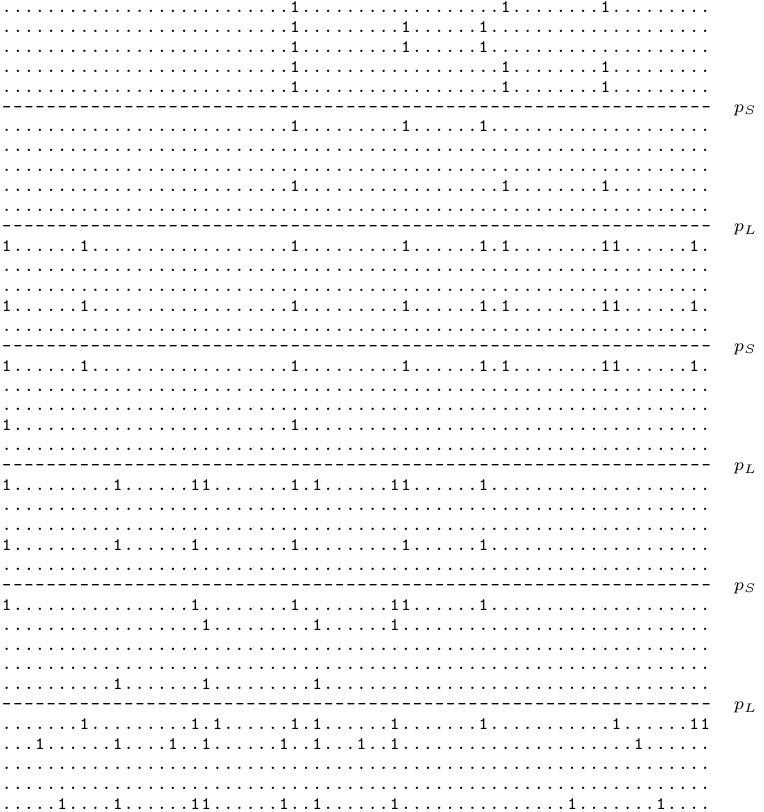
Figure 4: 4-round trail with 43 [5, 9, 9, 20] active Sboxes and weight 132 [11, 36, 30,